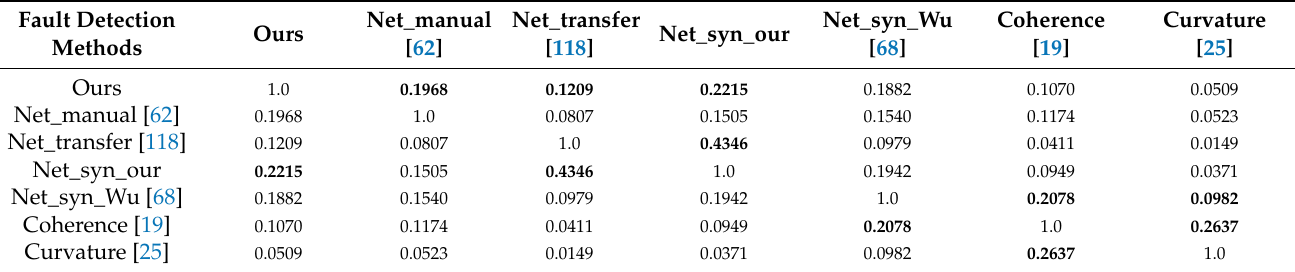
Table 3. Results Comparison Test with F1 Score in Work Area